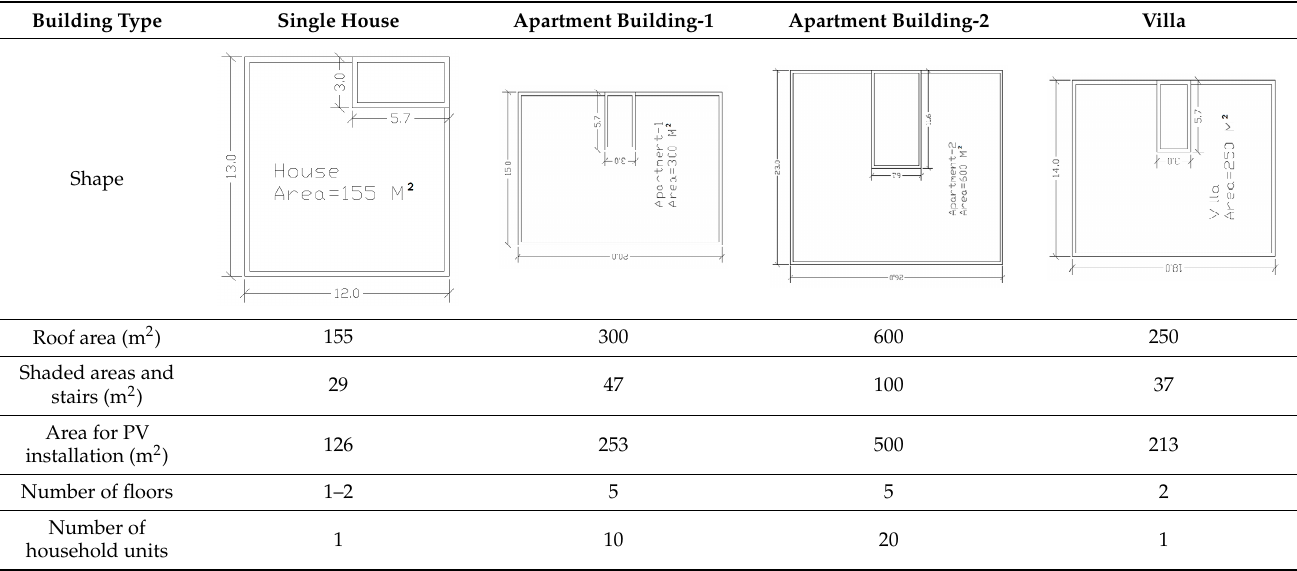
Table 1. Descriptions of the targeted buildings for rooftop PV installation.